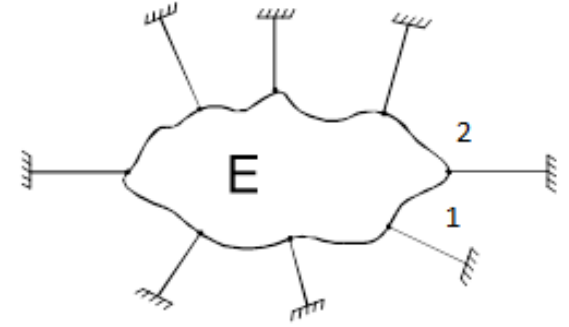
Fig. 2. Superelement E cooperating with beam type